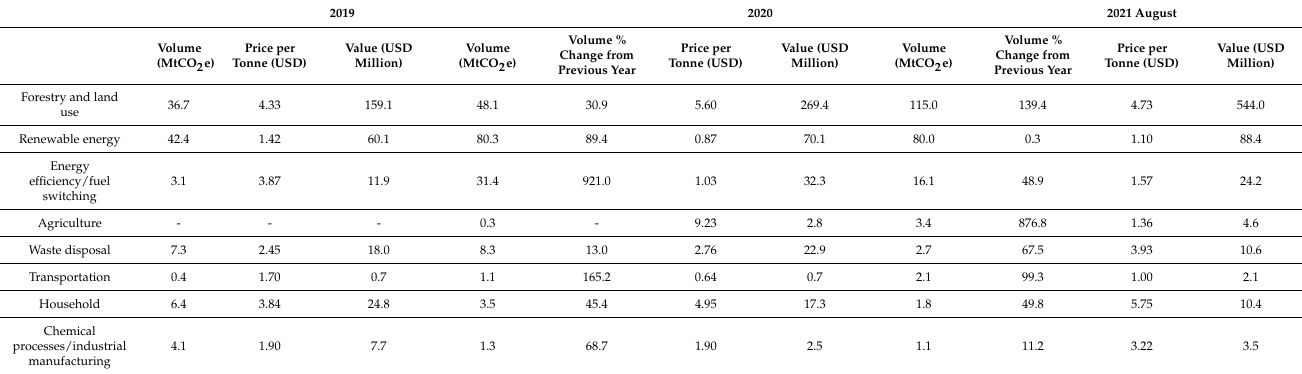
Table 2. Voluntary carbon market size by project category, 2019—2021